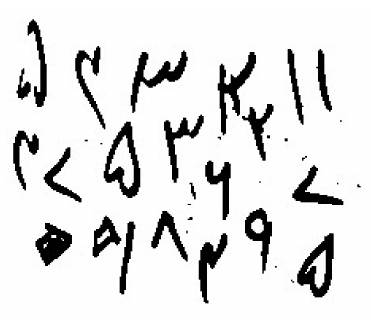
Figure 6. Low threshold level.